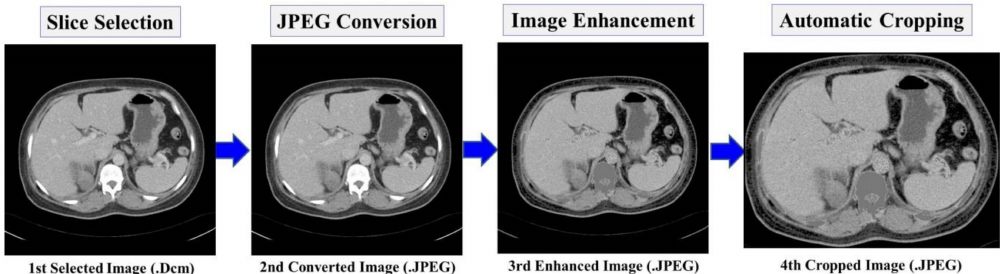
Figure 4. Preprocessing